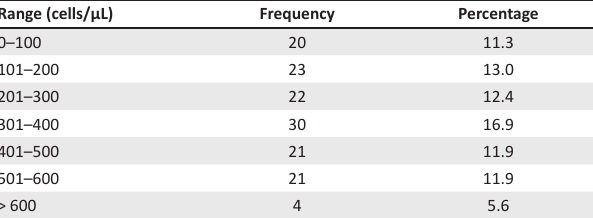
TABLE 3 : Distribution of CD4+ cell count range and number of lesions. Range (cells/μL)